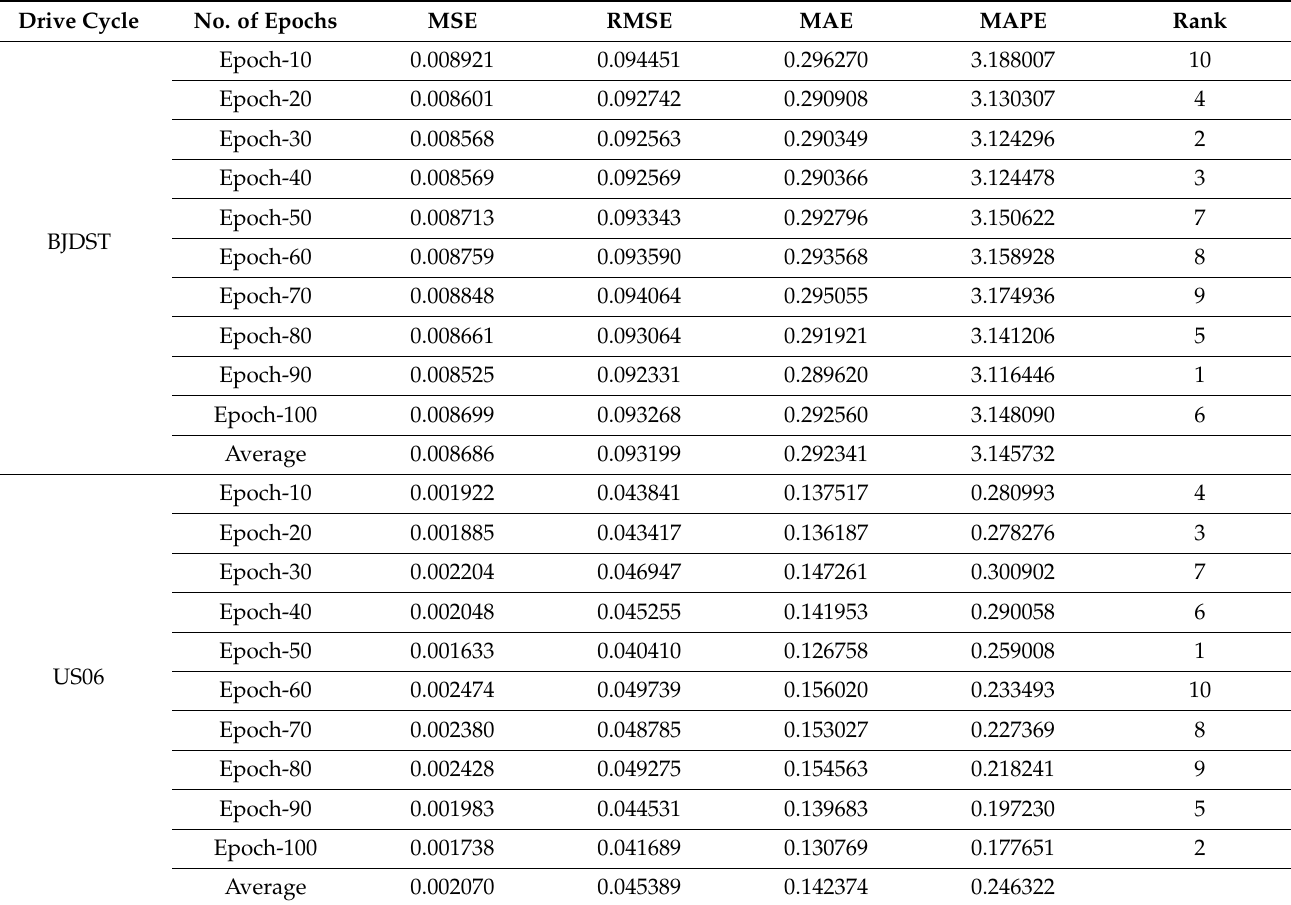
Table 1. SOC estimation results analysis of DLSOC-REM technique with different